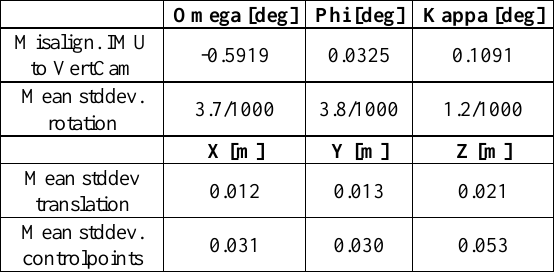
Table 5. Overview of AT for images of VertCam